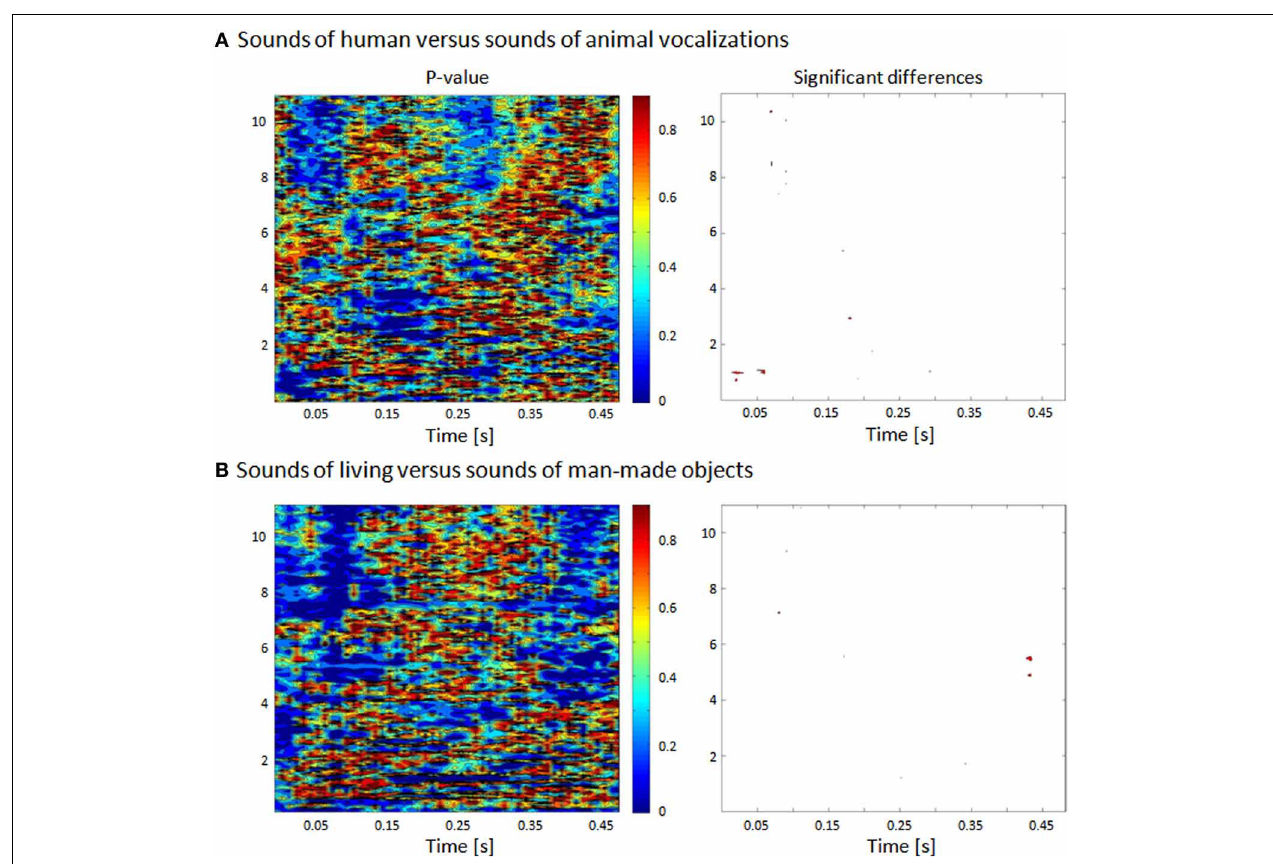
FIGURE 1 | Statistical comparison between human and animal vocalizations and between living and man-made sounds based on their frequency. (A)